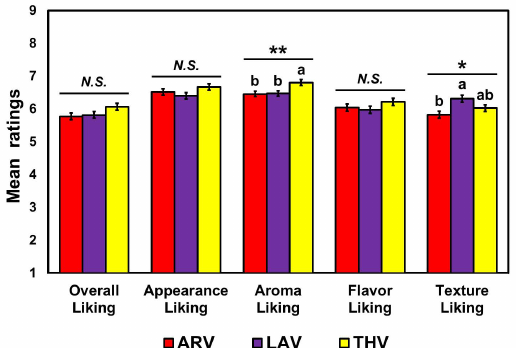
Figure 2. Comparisons among the three cooked aromatic rice samples: ARoma 17 (ARV), Jazzman-2 (LAV), and Thailand Jasmine (THV), with respect to hedonic ratings of attributes and overall impression. * and ** represent a significant difference at p < 0.05 and p < 0.01, respectively. Different letters with mean ratings within a category indicate a significant difference at p < 0.05. N.S. represents no significant difference at p < 0.05.